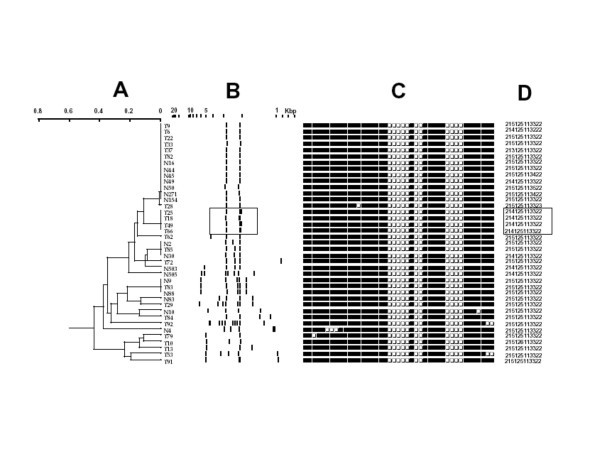
Partial UPGMA tree constructed by combined numerical analysis of IS6110-RFLP and spoligotyping data using Taxotron, and built on isolates bearing ST41 spoligotypes and variants. A: unrooted dendrogram with dissimilarity index scale, B: IS6110-RFLP patterns, C: spoligotyping pattern (binary representation), D: MIRU genotyping values for ST41 clinical isolates. Note the association of value 4 of MIRU10 and the IS6110-RFLP cluster defined by isolates T25, T18, T49, T66 and the observation of a double band at 2.2 kb.